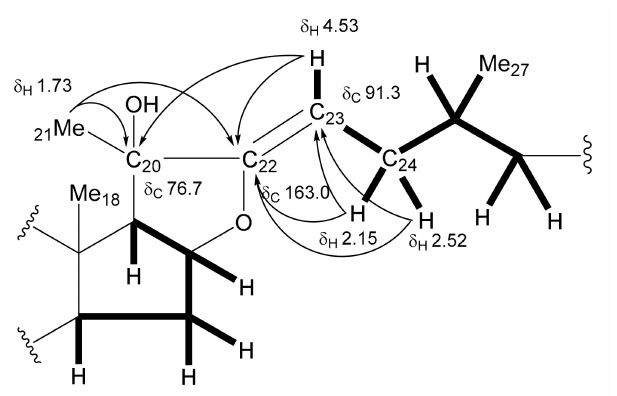
Figure 2. Heteronuclear multiple-bond correlation (HMBC) correlations of 13 . Bold lines indicate the